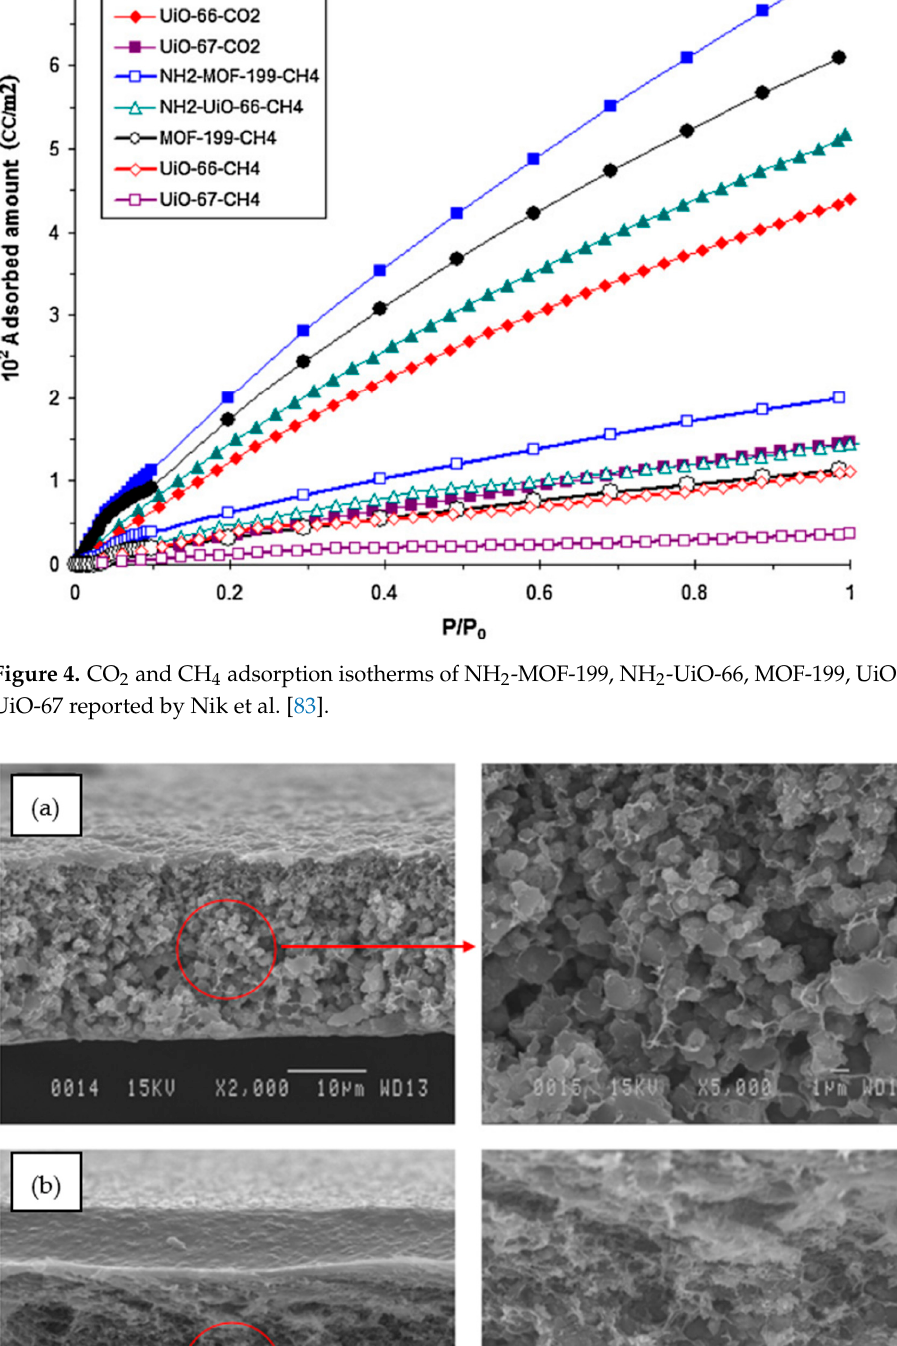
the addition of the -NH 2 group in NH 2 -UiO-66/6FDA–ODA, the filler/polymer interfacial